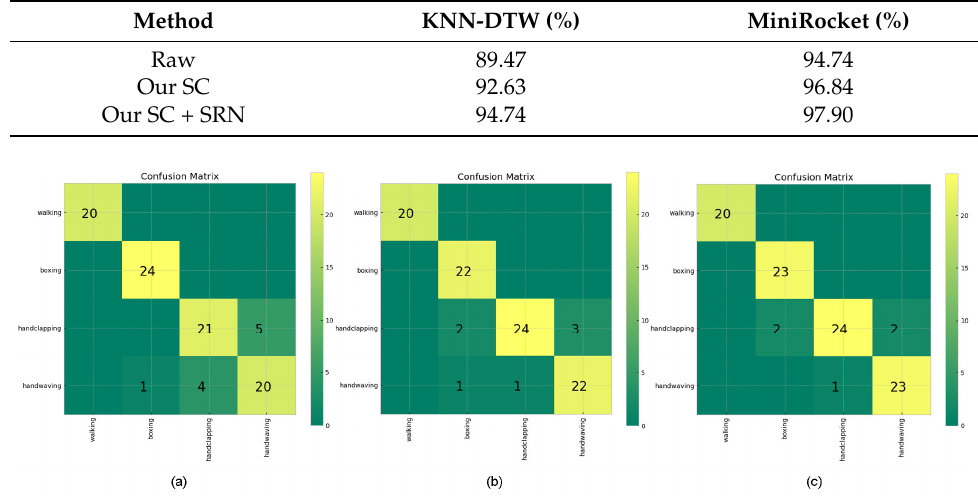
Figure 5. Covariance matrix for classification with KTH-4 using different methods of processing combined with KNN-DTW networks. ( a ) Raw, ( b ) SC, ( c ) SC + SRN.